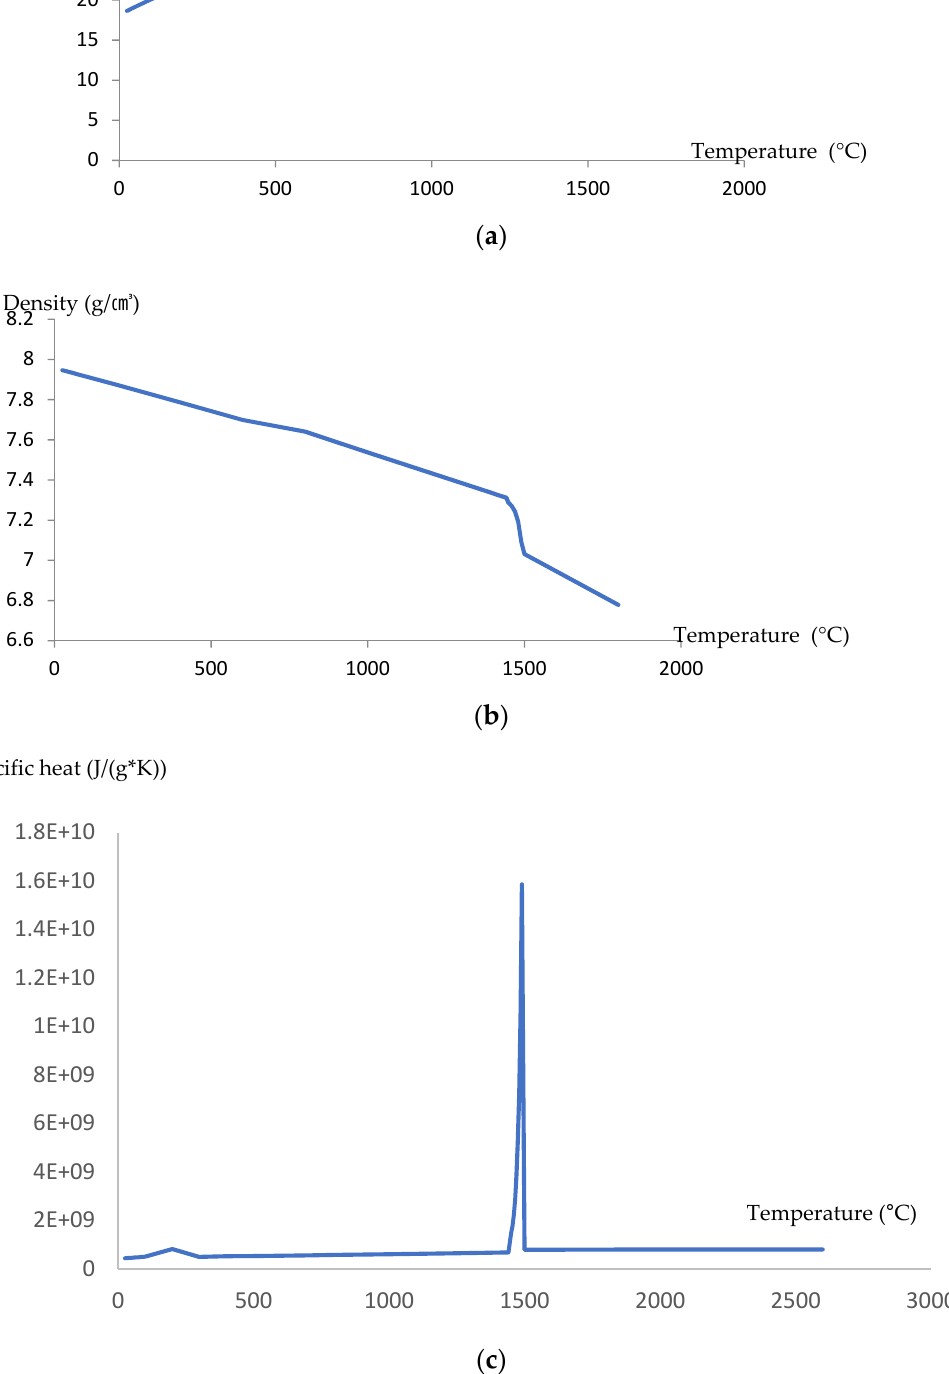
Figure 5. Material properties of 9% nickel steel by temperature. ( a ) Conductivity; ( b ) density; ( c ) specific heat.